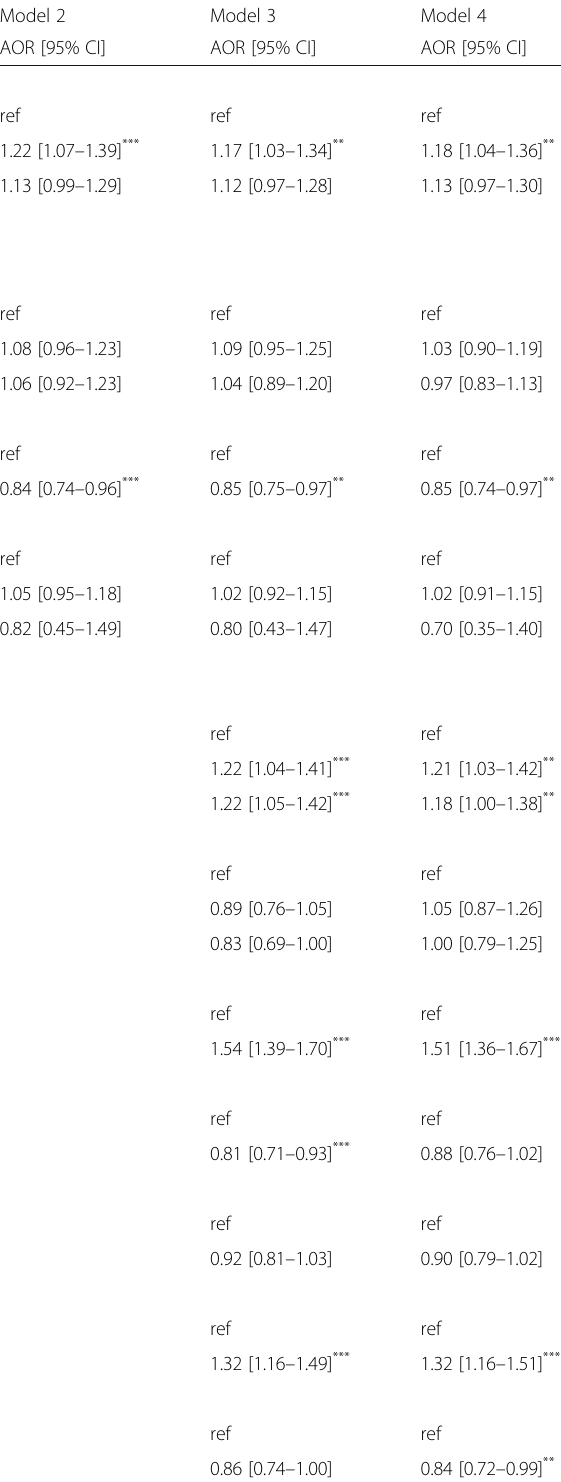
Table 3 Effects of biomass fuel use, residential factors, and mother and child characteristics on respiratory symptoms based on sequential multiple logistic regression